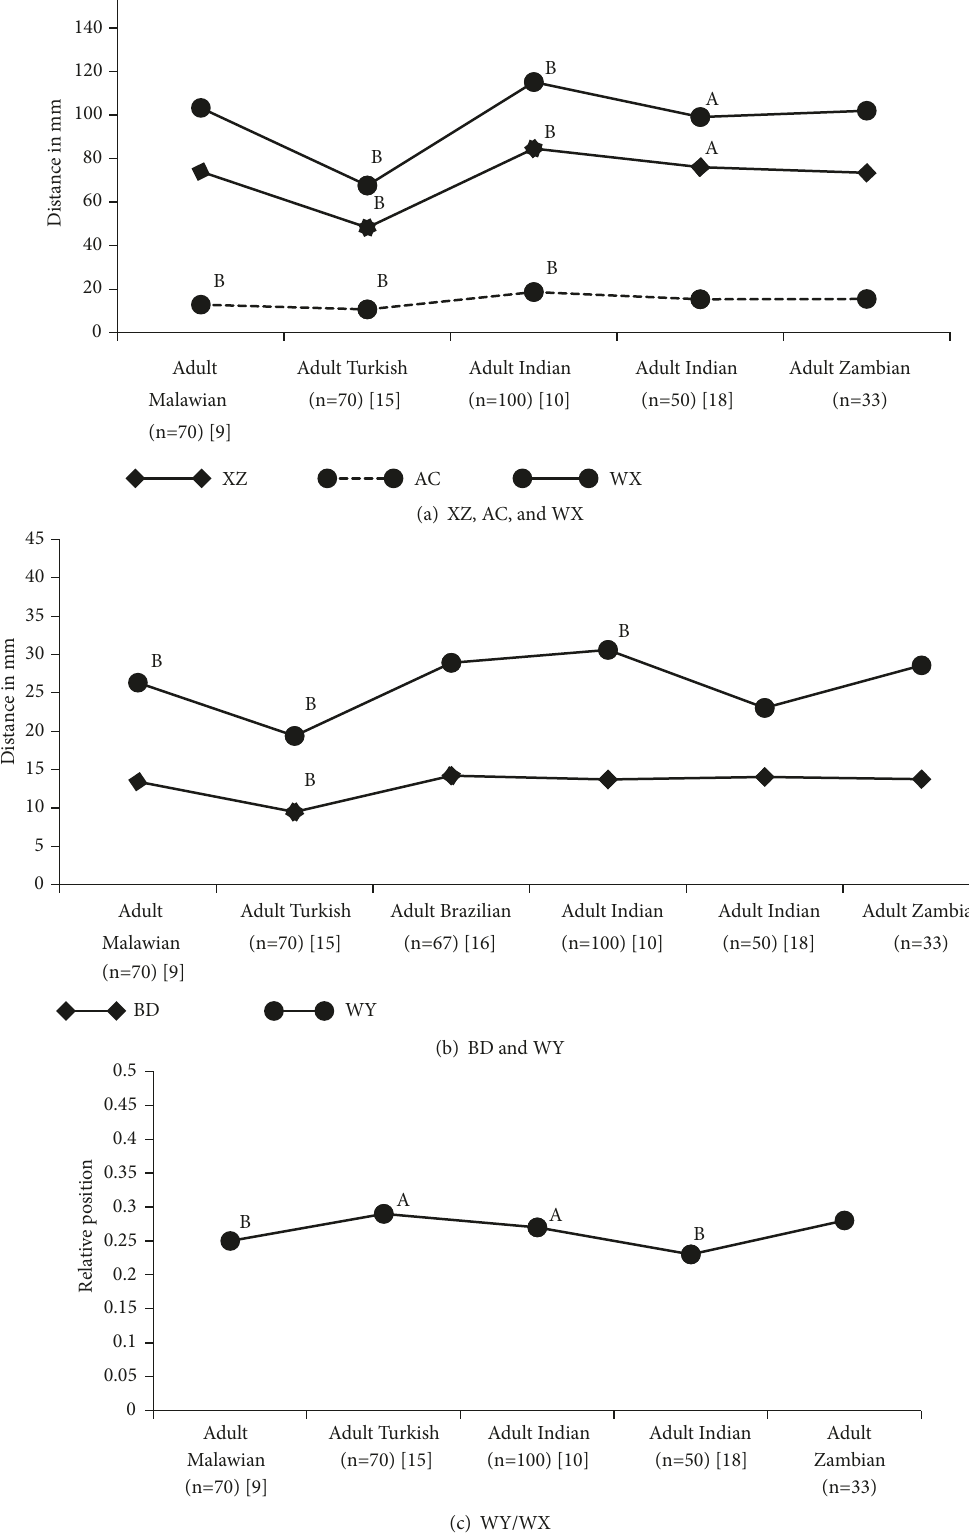
Figure 6: The mandibular anthropometrics of the left side of mandibles among different ethnic groups on different geographic locations: comparative analysis with other reported values. AC: distance (in mm) from alveolar crest to upper margin of mental foramen, BD: distance (in mm) from lower border of mandible to lower margin of mental foramen, WY: distance (in mm) from symphysis menti to medial margin of mental foramen, XZ: distance (in mm) from posterior border of ramus of mandible to lateral margin of mental foramen, WX: length of mandibles, and WY/WX: relative position. A Significant at p < 0.05; B significant at p <